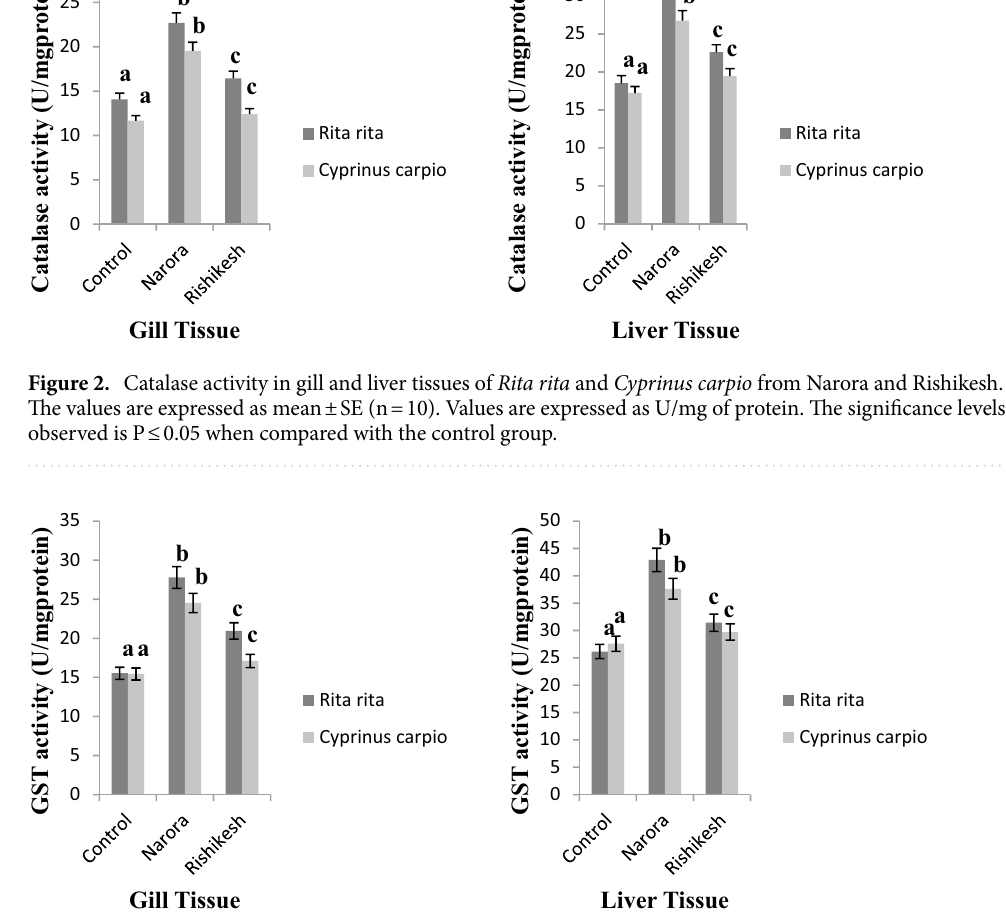
Figure 3. GST activity in gill and liver tissues of Rita rita and Cyprinus carpio from Narora and Rishikesh. The values are expressed as mean ± SE (n = 10). Values are expressed as U/mg of protein. The significance levels observed is P ≤ 0.05 when compared with the control